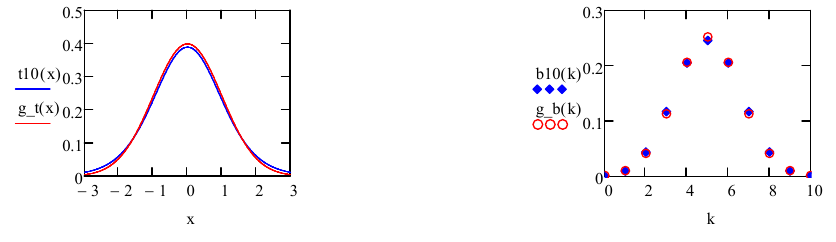
Figure 2. Normal approximations for Student’s t ( left , ν = 10) and Binomial ( right , n = 10)